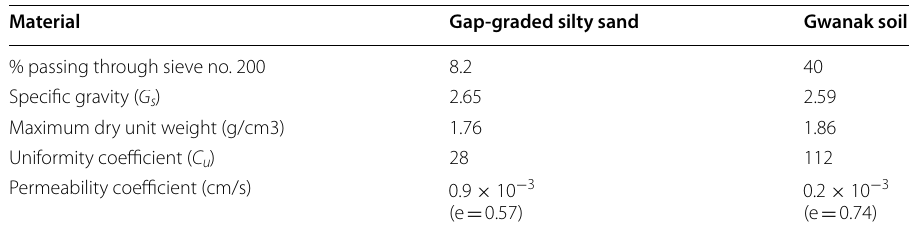
Table 1 Properties of gap‑graded silty sand and Gwanak soil Material Gap-graded silty sand Gwanak soil % passing through sieve no.